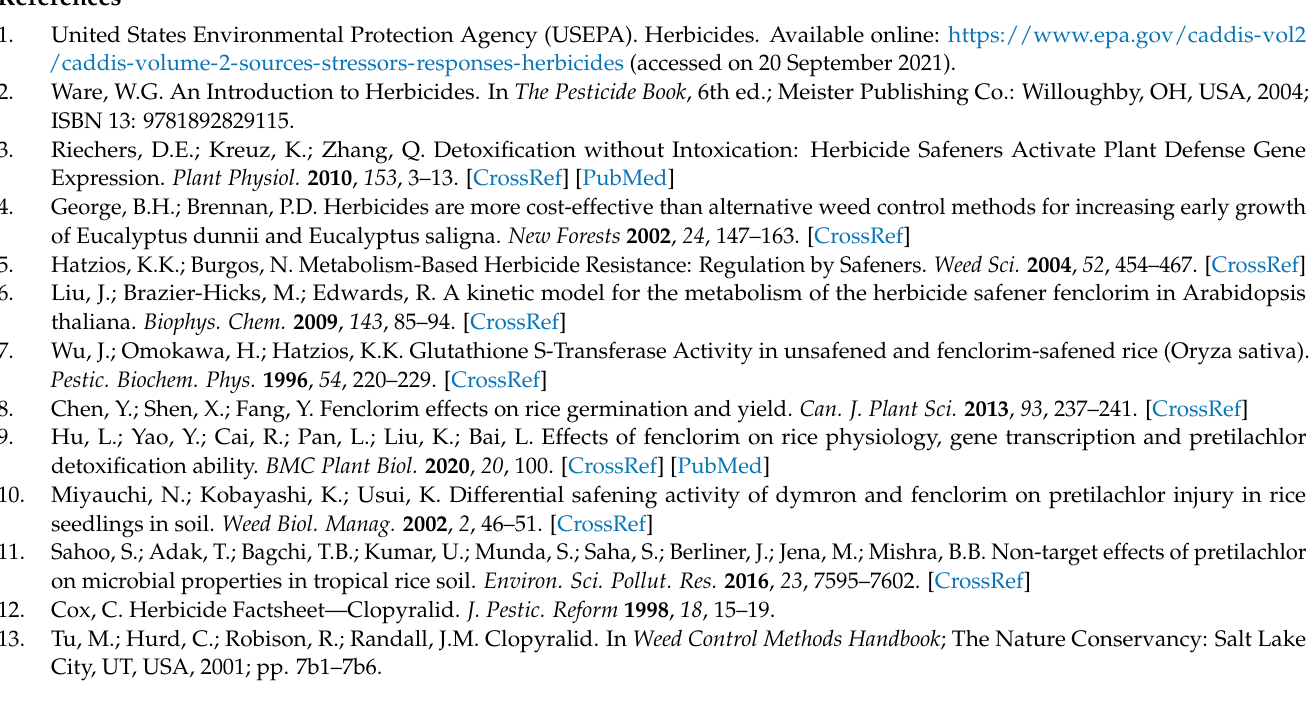
Specific densities of fenclorim and clopyralid. Table S2. DSC results: temperatures, molar enthalpies and entropies of fusion of fenclorim and clopyralid. Table S3. Standard molar heat capacity results, at T = 298.15 K, for fenclorim and clopyralid. Table S4. Effusion vapor pressure results for crystalline fenclorim. Table S5. Effusion vapor pressure results for crystalline clopyralid. Table S6. Calculated absolute enthalpies, H , (in Hartree, Eh) of all considered molecules estimated using G3(MP2)//B3LYP. H o m (g). Table S7. Working reactions and computed enthalpies of reaction, Literature values of ∆ f ∆ ∆ o H o m , of fenclorim in the gaseous phase, at T = 298.15 K. Table S8. Working r H m , and formation, f reactions and computed enthalpies of reaction, ∆ r H o m , and formation, ∆ gaseous phase, at T = 298.15